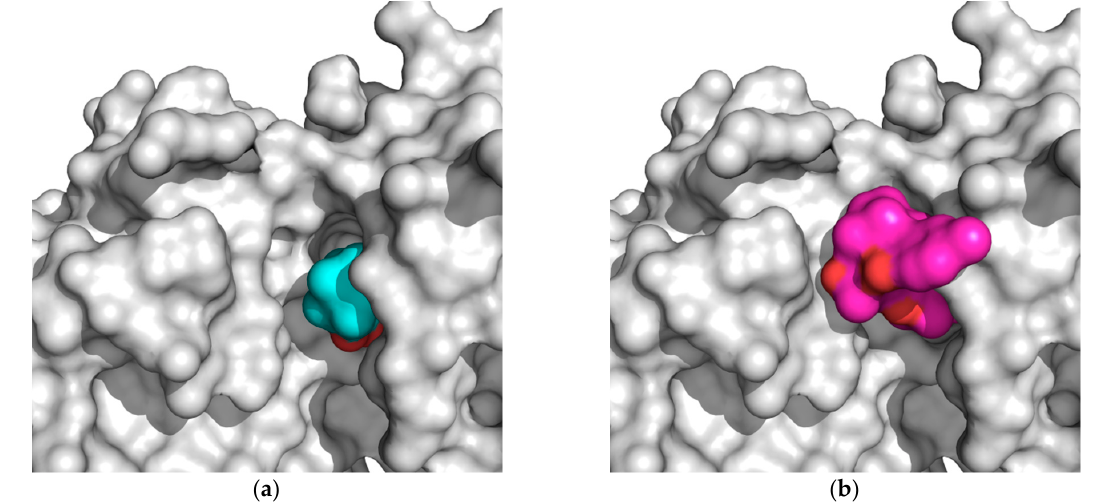
Figure 4. ( a ) Deeply bound and less exposed conformation of DeRoy ( 1 , cyan) in PKC (white); ( b ) more exposed bound conformation of RoyBzCl ( 5 , magenta) in PKC (white). All molecules in solvent-accessible surface area representation.